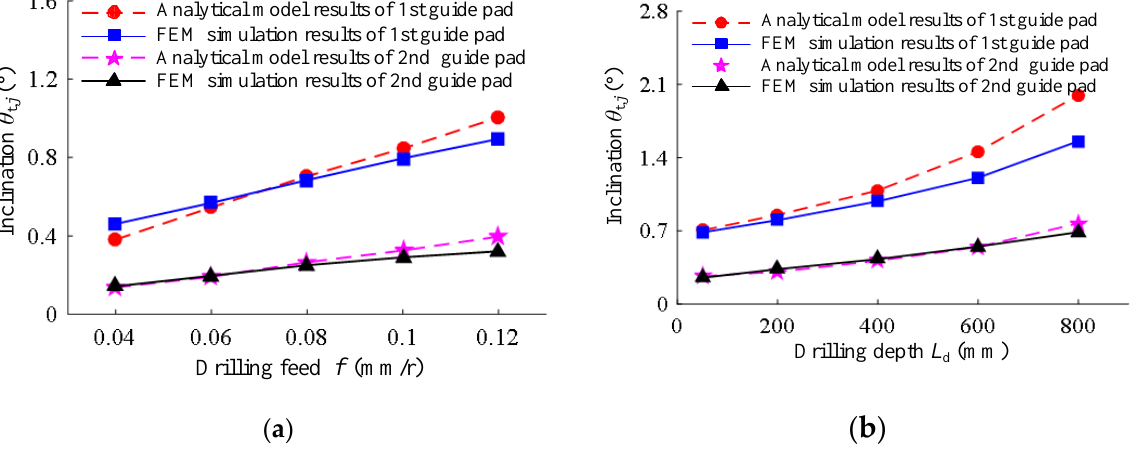
Figure 9. The contact inclination angle from the analytical model results and FEM simulation results: ( a ) under different drilling feeds of drilling speed n = 1200 r/min and drilling depth L d = 50 mm; ( b ) under different drilling depths of drilling speed n = 1200 r/min and feed rate f = 0.08 mm/r.